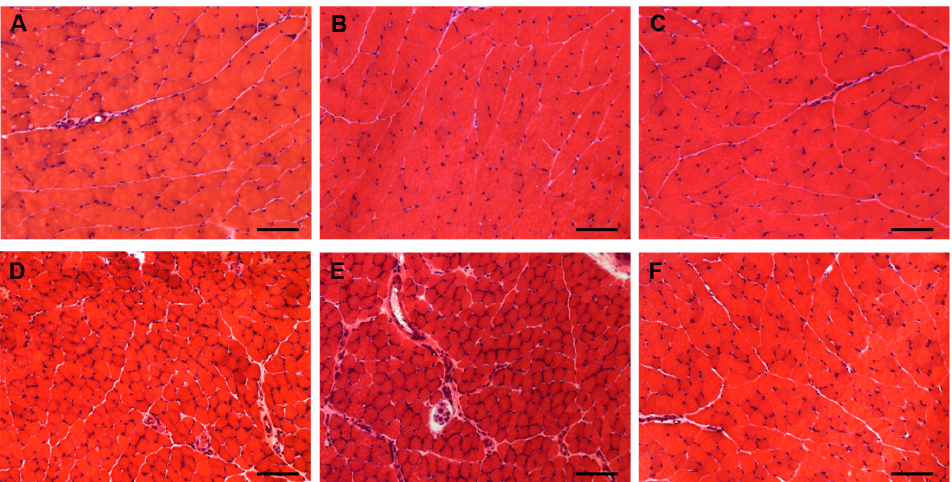
Figure 4. Light microscopy of gastrocnemius ( A – C ) and tibialis anterior ( D – F ) muscles from control mice ( A , D ) and mice treated for 7 ( B , E ) or 14 days ( C , F ) with bortezomib. H&E stain shows no morphological abnormalities in control mice and in mice treated with bortezomib. Images were obtained with obj ×20. Bars: 100 μ m.